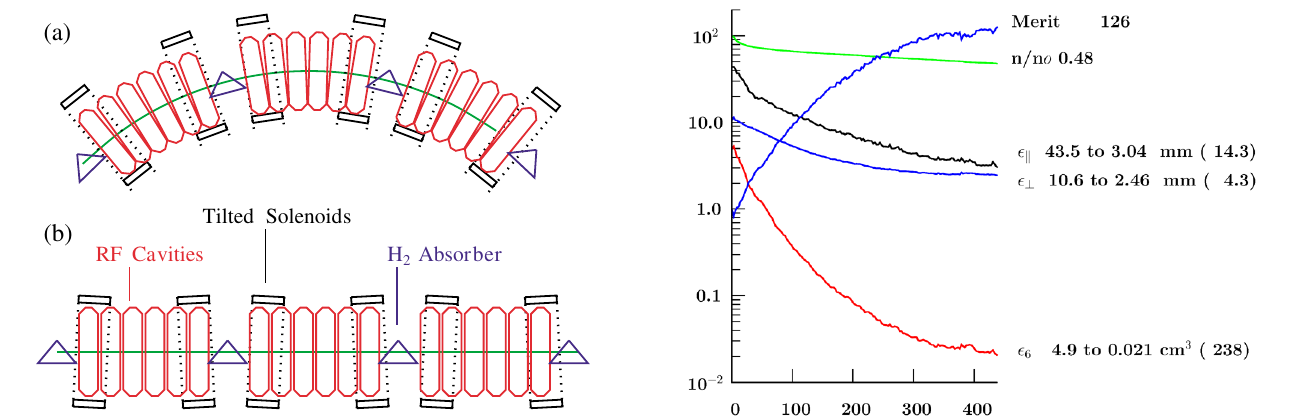
FIG. 38. (Color) Three cells of the RFOFO lattice; (a) plan, (b)